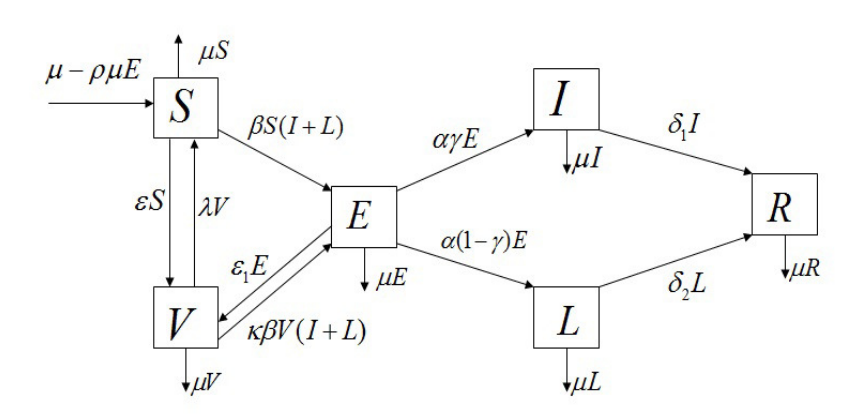
Figure 1. Flowchart of mumps transmission in a